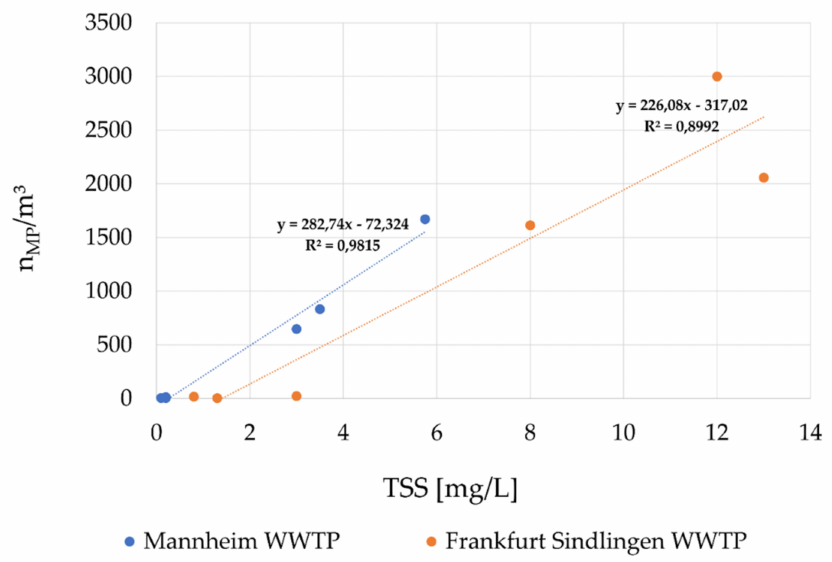
Figure 11. Correlation between microplastic (MP) concentration and total suspended solids (TSS) of all samples from the Mannheim WWTP and the Frankfurt Sindlingen